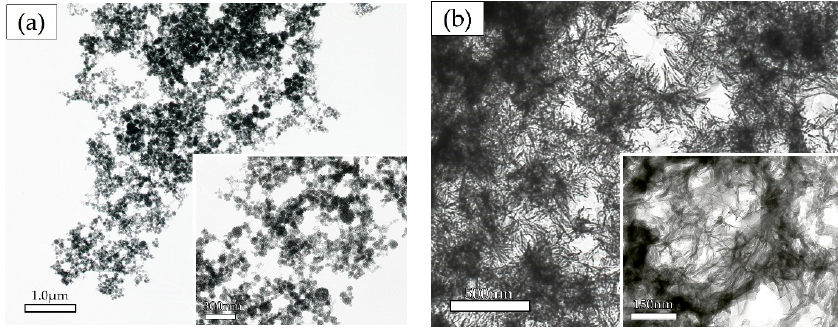
Figure 5. TEM images of the precipitate with 0.025% ox-LDL: ( a ) 12.02 mM calcium and 6.70 mM phosphate; ( b ) 39.33 mM calcium and 21.92 mM phosphate.